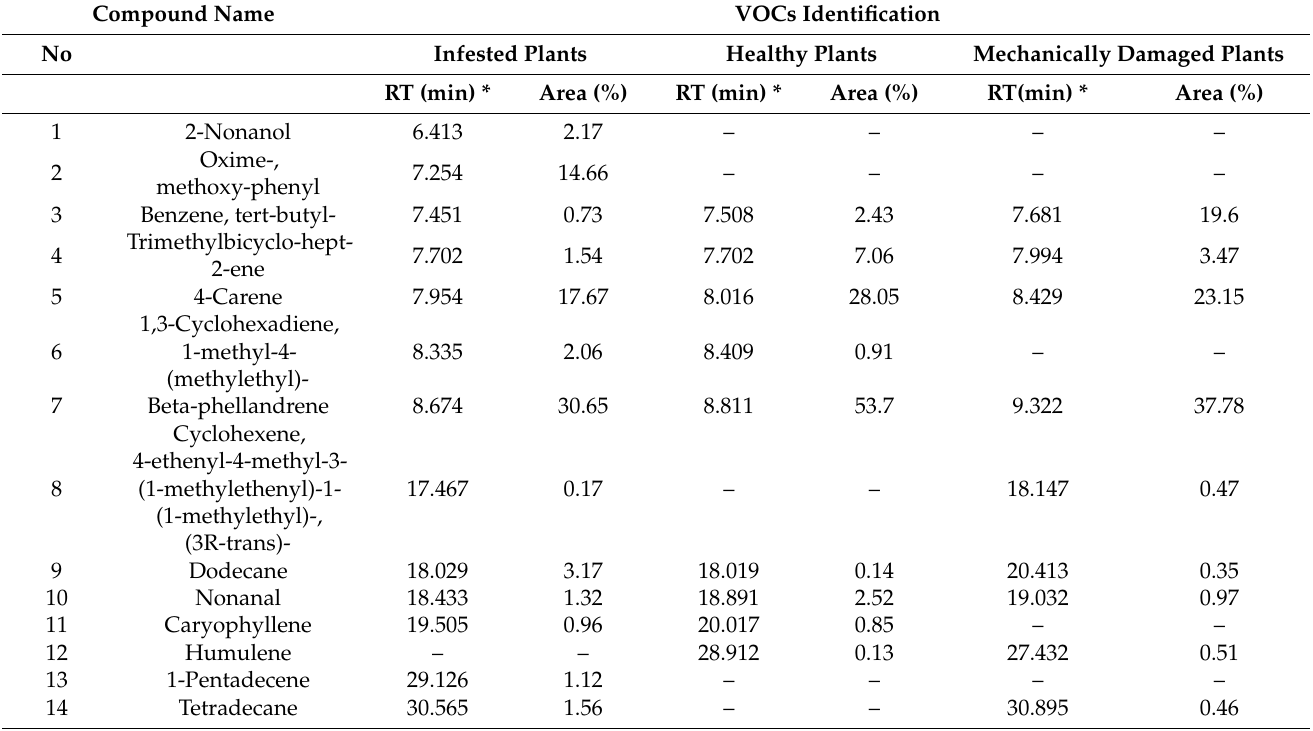
Figure 7. A typical GC-MS spectrum of VOCs from a whitefly-infested tomato plant. Table 2 lists the VOCs with averaged concentration in healthy plants, infested plants, and mechanically damaged tomato plants. Besides the aforementioned two new com- pounds, n-hexadecanoic acid was also found in the infested plants. In comparison with healthy plants, the concentrations of 4-carene (from 28.05% to 14.66%) and beta- phellandrene (from 53.7% to 30.65%) significantly decreased after infestation by whiteflies, while the new compound oxime-, methoxy-phenyl had a significantly high concentration (17.67%). One of the probable reasons was that some of the VOCs of healthy plants might be generated from a different synthesis path and be configured as new compounds with the ability to combat the infestation and to deliver messages for communication between plants. All those findings indicated that VOC profiles of tomato plants changed after infestation. Such variations provided fundamentals for E-nose system development. Table 2. Typical VOCs released from whitefly-infested tomato plant, healthy plant, and mechanically damaged plant.